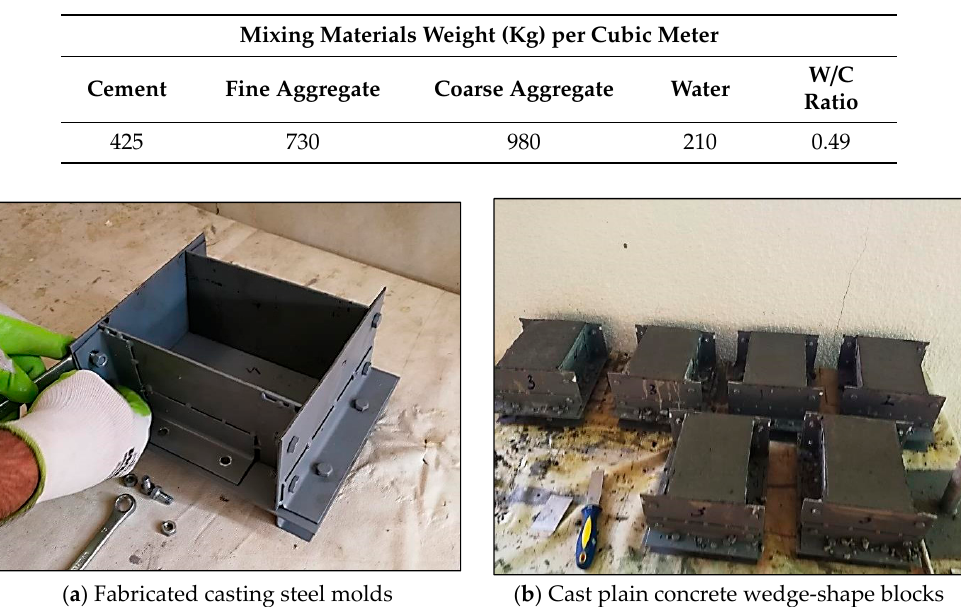
Figure 3. Fabrication of plain concrete wedge-blocks.